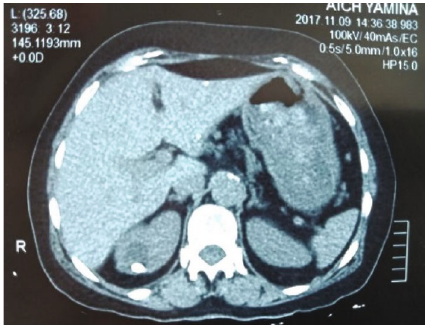
Figure 4: CT demonstrates a 10 mm stone-bearing diverticulum with 750 UH of density situated in the pole with the holmium laser.